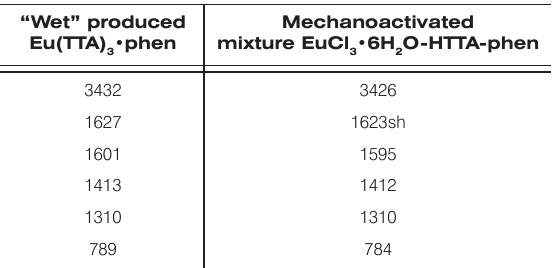
Figure 4. SEM images of unactivated EuCl complex; fluorescence microscopy image of the mechanochemically obtained product, x160 Table 3. Characteristic bands (cm -1 ) in the IR spectra of the studied products. “Wet” produced Eu(TTA) •phen 3